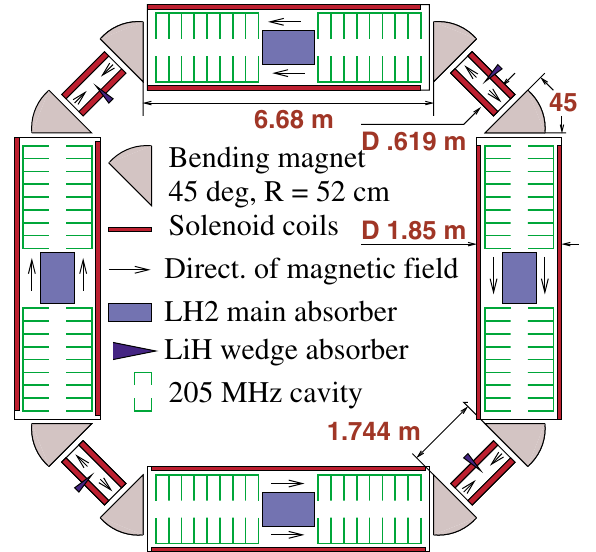
FIG. 34. (Color) Layout and parameters of the solenoid based ring cooler. Circumference: 36.963 m; nominal energy at short straight section: 250 MeV; bending field: 1.453 T; normal field gradient: 0.5; maximum solenoid field: 5.155 T; rf frequency: 205.69 MHz; accelerating gradient: 15 MeV = m; main absorber length: 128 cm; LiH wedge absorber: 14 cm; gradient of energy loss: 0.75 MeV =